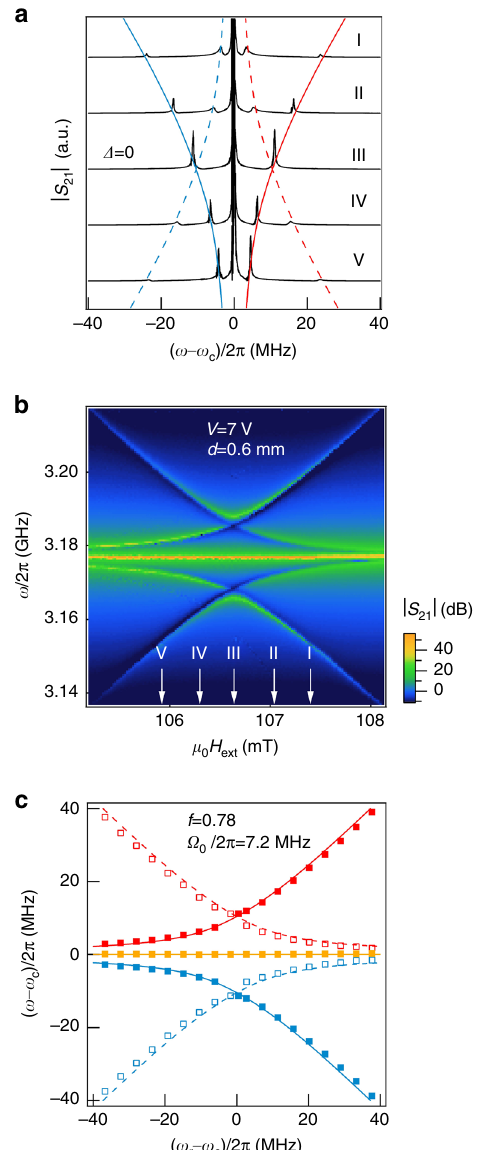
Fig. 4 Magnetic fi eld dependent measurement. a | S 21 | spectra measured at d = 0.6 mm ( Ω π = 7.2 MHz) and V = 7 V ( f = 0.78), for fi ve different H 0 /2 fi elds as marked in b . The dispersion of the measured magnon quintuplet is plotted as a function of b , the magnetic fi eld H , and c , the detuning Δ /2 π . The curves in c are calculated by using eq. Distance d dependent Rabi frequency . We begin our study with the feedback switched off ( V = 0) and with an intra-cavity photon number of about 10 6 . Figure 2a shows the | S 21 | spectra measured at zero detuning ( Δ = 0). Within the broad cavity mode of Q = 25, a dip appears at ω c /2 π = 3.160 GHz. This is the char- acteristic spectral response of CMP in the regime of magnetically induced transparency 5 de fi ned by 1 = 2 Q > Ω 0 = ω c > α . The Rabi frequency Ω 0 depends on d since the rf fi eld of the P-cavity increases with decreasing d . By fi tting the | S 21 | spectra using the CMP theory 5, 11, 12 , we deduce Ω 0 and plot the Ω 0 − d dependence in Fig. 2b (the solid circles).